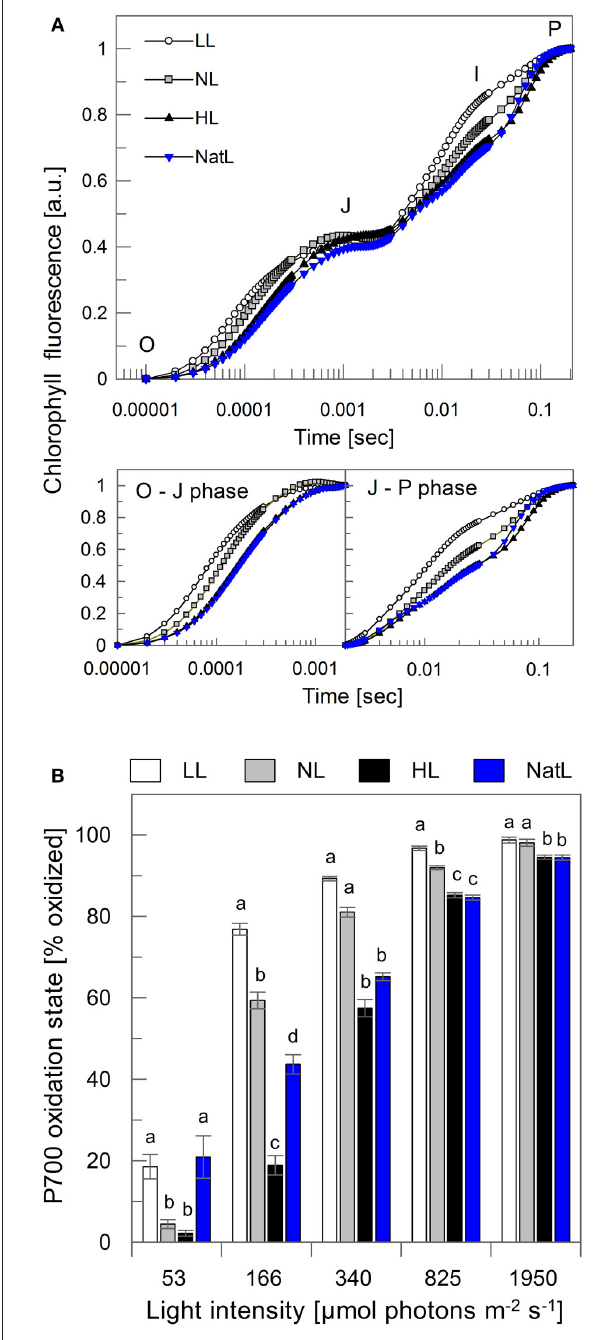
FIGURE 5 | Electron transfer from PSII to PSI. (A) Chl fluorescence induction transients normalized to the total amplitude from the O to the P state (upper panel). The lower panel depicts the O to J phase (left) and the J to P phase (right), again normalized to the respective total amplitude. The normalization allows for direct comparison of the fluorescence induction kinetics. O, original fluorescence, corresponding to Fo; J and I, intermediate states; P, fluorescence peak, corresponding to Fm. Mean values of 10 measurements are shown, SD was < 0.04. (B) P700 oxidation state at five different illumination intensities. Mean values ± SE of at least five independent samples are shown. Significant differences (Holm-Sidak or Dunn’s test, p < 0.05) are